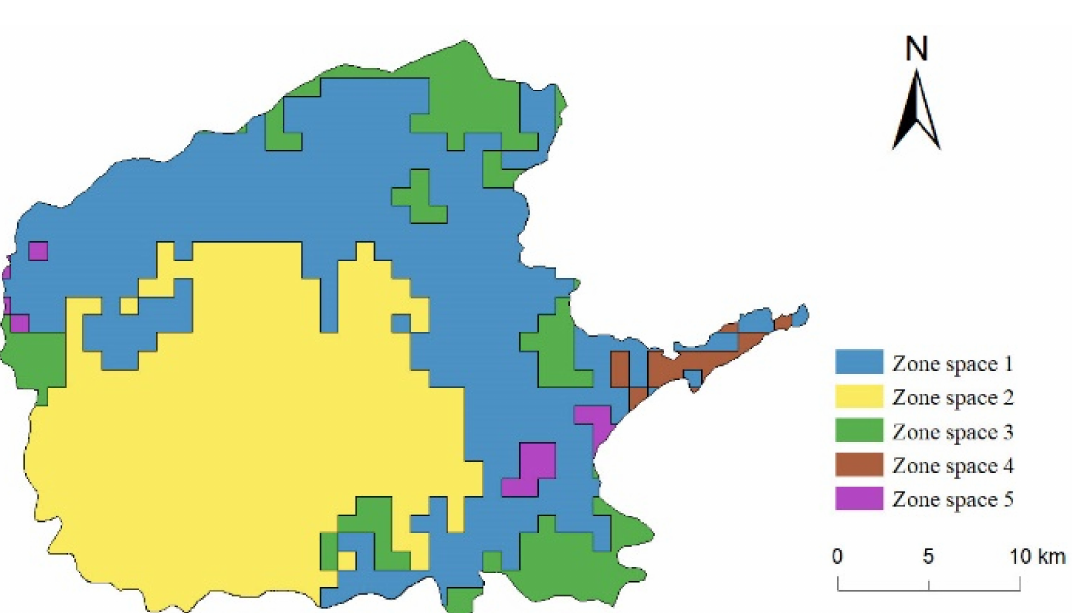
Figure 10. Zoning group ecosystem service